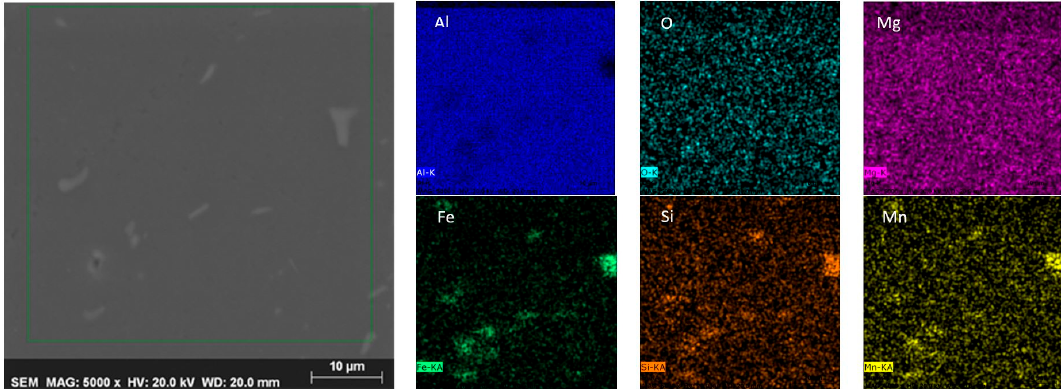
Figure 9. SEM and energy-dispersive X-ray spectroscopy (EDX) element mapping for SSR sample 12.